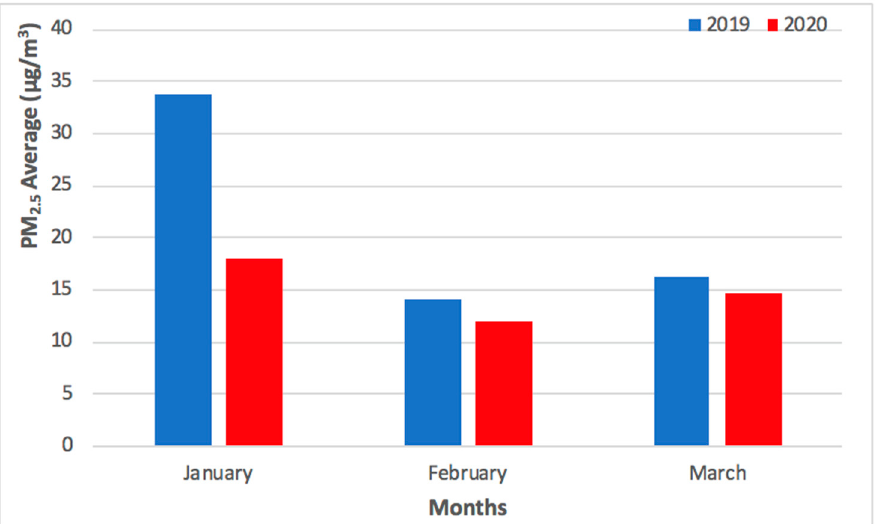
Figure 5. Monthly mean PM 2.5 concentrations for Taipa Ambient during the previous year of 2019 and COVID-19 pandemic in 2020 (January to March). Int. J. Environ. Res. Public Health 2020 , 17 , x 12 of 19